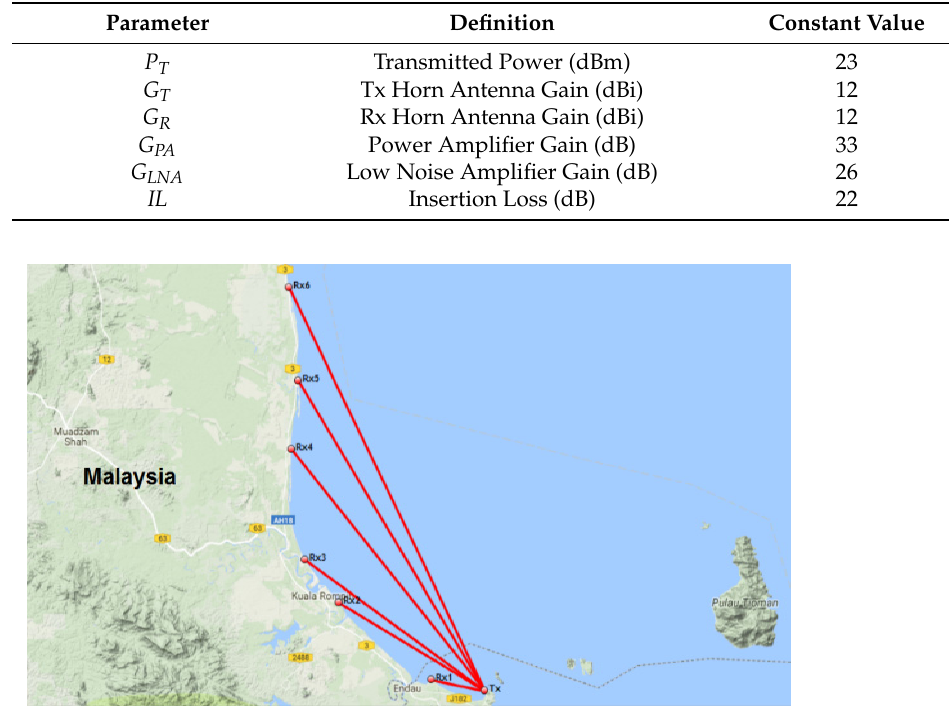
Table 1. Constant parameter values for measurement campaign.